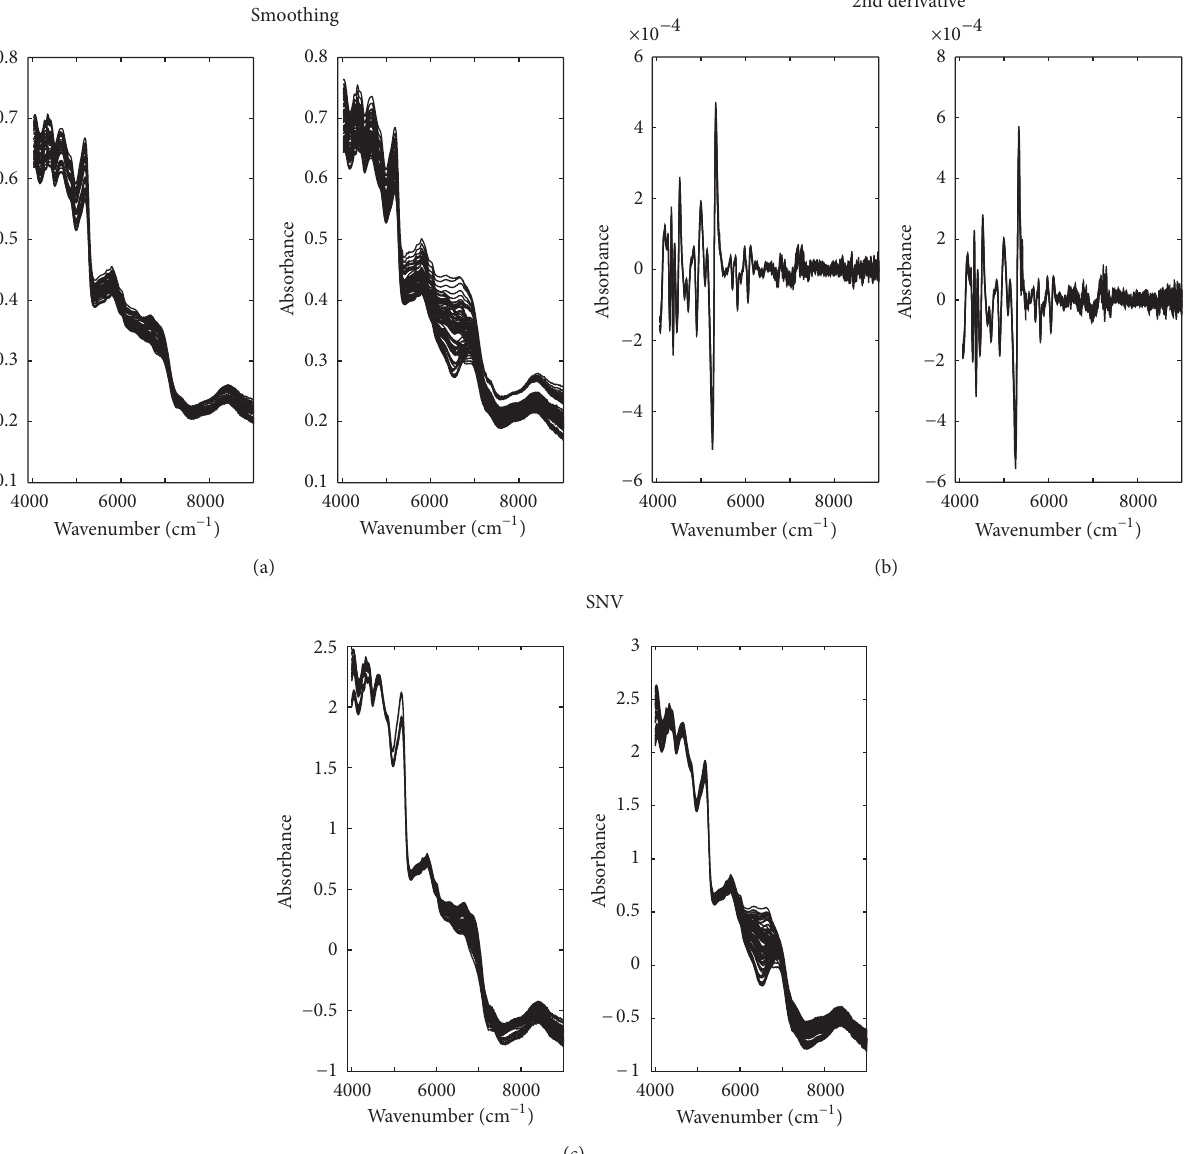
F 2: Some of the preprocessed spectra of Anji-white (le) and non-Anji white (right) tea samples by smoothing, taking derivatives, and